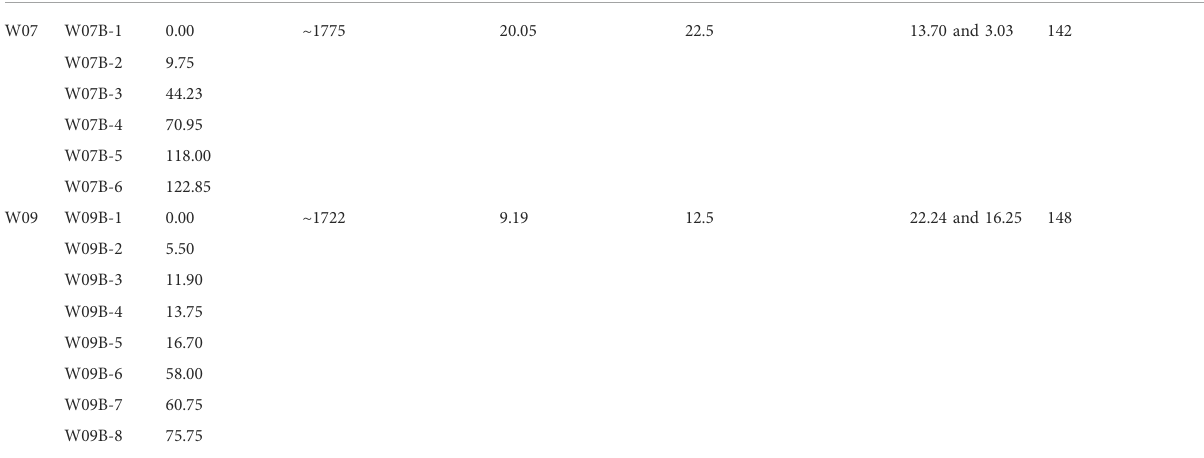
TABLE 1 Information of samples from site GMGS5-W07 and GMGS5-W09.